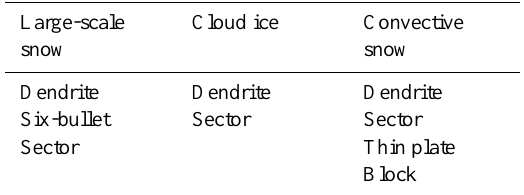
Table 3. Frozen hydrometeor shapes used in the fine search, ranked roughly from lowest to highest scattering.